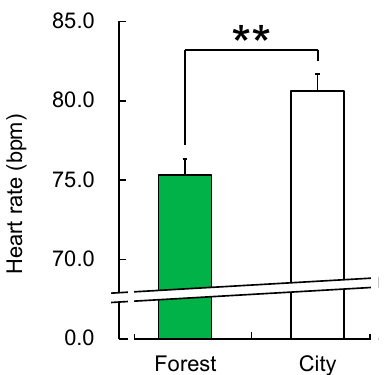
Figure 4. Heart rate during viewing forest and city areas. Data are shown as means ± standard error ( n = 65). ** p < 0.01, paired t -test (one-sided).